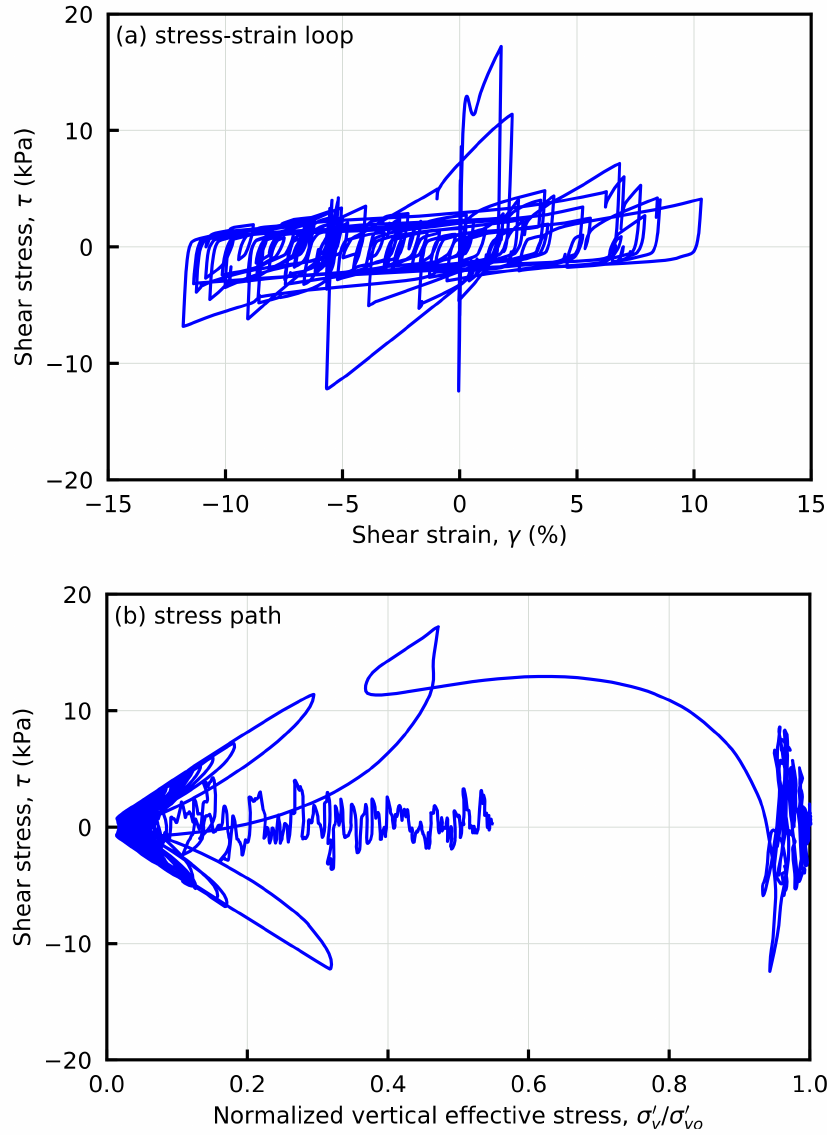
Figure 21. Dynamic response at the central element of L4 layer during the earthquake. ( a ) stress-strain loop; ( b ) stress path.